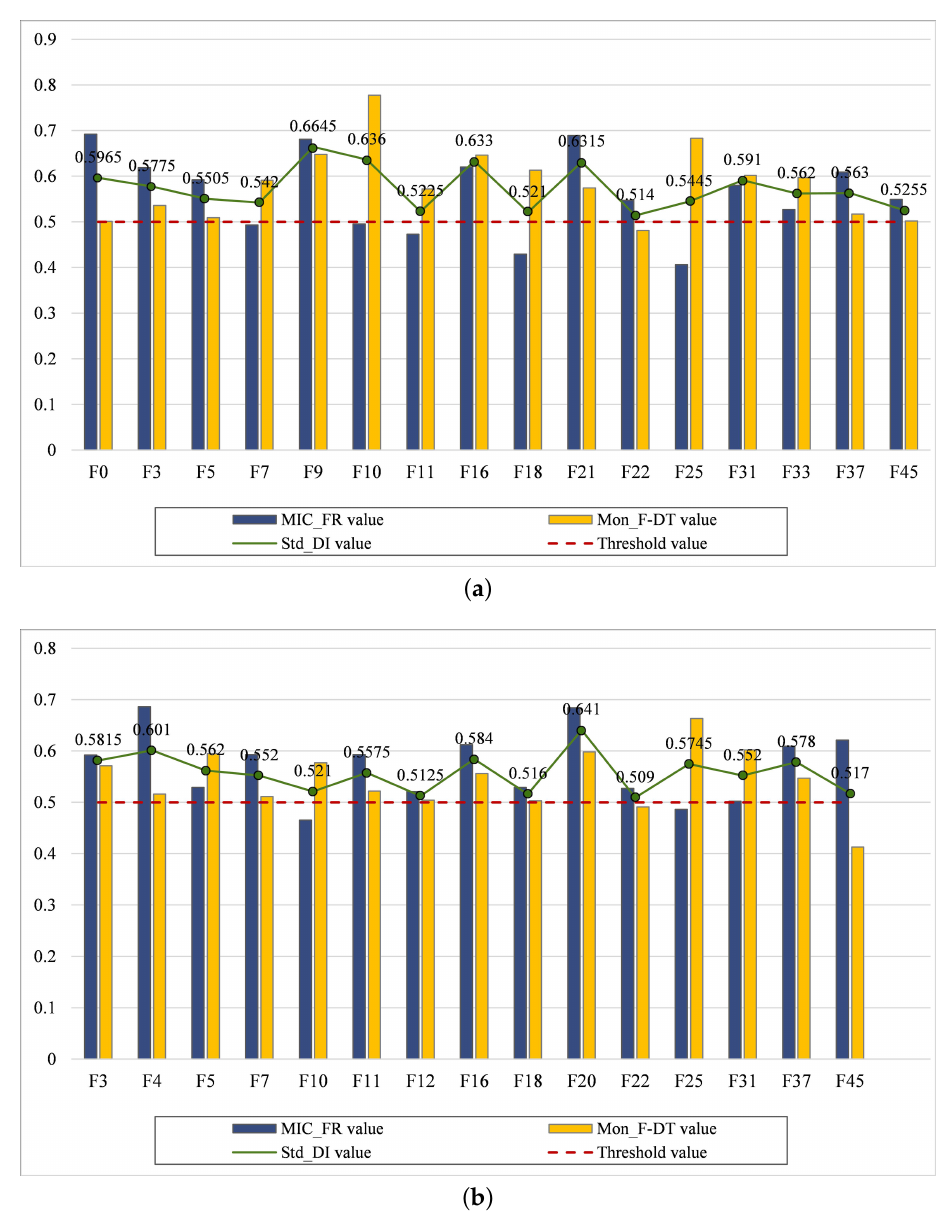
Figure 11. Features in the final optimal feature set Opt DI . ( a ) Features in the final optimal feature set Opt DI under working condition B, ( b ) Features in the final optimal feature set Opt DI under working condition